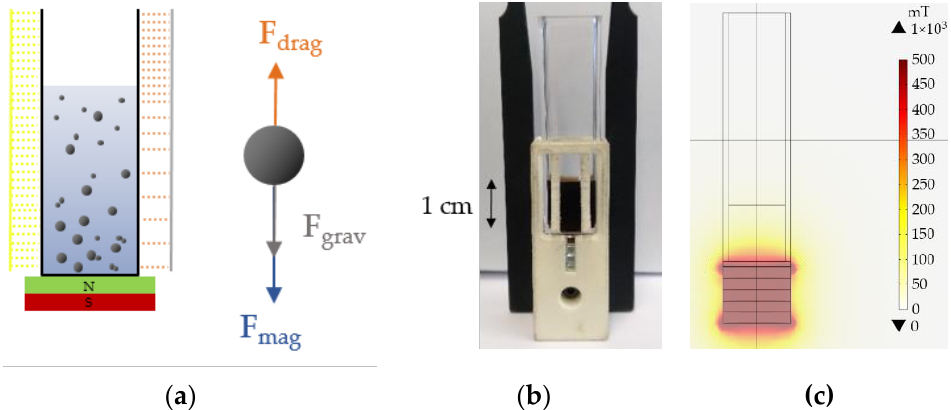
Figure 3. ( a ) Schematic illustration of the sedimentation analyzer (LUMiReader) with the involved forces (magnetic force F mag , the gravitational force F grav , and the drag force F drag ). ( b ) Experimental set-up. The cuvette filled with sample fluid is placed on a magnet, and parallel light with a wavelength of 870 nm transmits the sample. A light sensor records transmission profiles, and the magnetophoretic velocity of the particles is calculated. The magnetic flux density in the direction of the particle movement is 40 mT at the sample top and 350 mT at the sample bottom. ( c ) Calculated magnetic flux density along the y -axis. Calculations were performed with COMSOL Multiphysics 5.6.